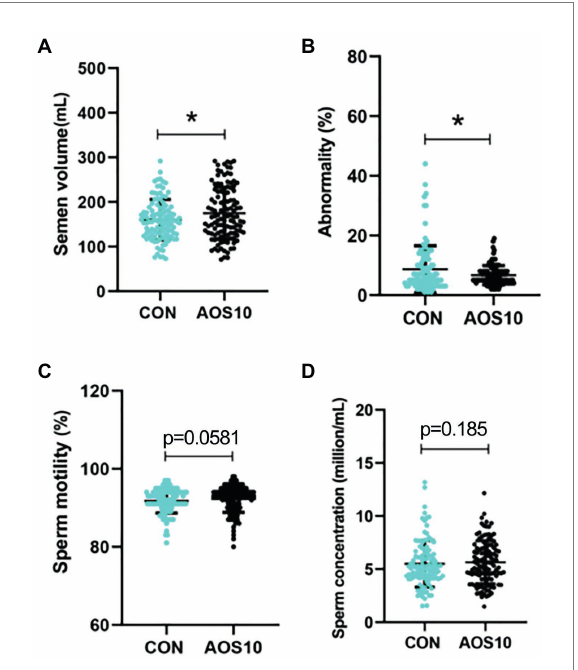
FIGURE 7 Long-term effects of AOS on boar semen quality. After AOS supplementation, boars were fed with basal diet for 8 weeks. Semen quality was determined every 5 days for 2 months (no AOS supplementation). (A) Semen volume. Y-axis = volume (ml), X-axis = treatment group (mg/kg body weight). (B) Abnormal sperm. Y-axis = % of total cells, X-axis = treatment group (mg/kg body weight). (C) Sperm motility. Y-axis = % of total cells, X-axis = treatment group (mg/kg body weight). (D) Sperm concentration. Y-axis = sperm concentration (10^8/ ml), X-axis = treatment group (mg/kg body weight). n = 10, * p <